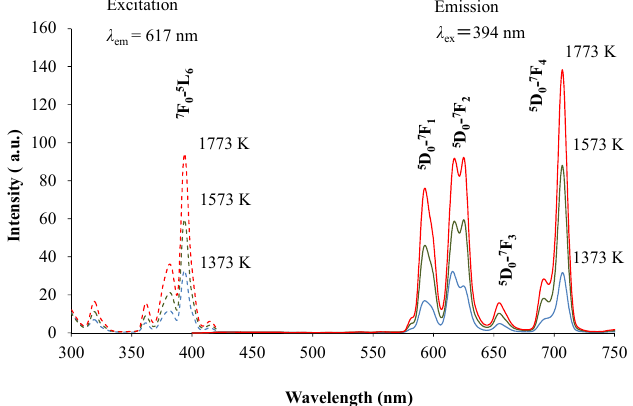
Figure 1. XRD patterns of (Ca 1.95 Eu 3+0.02 □ 0.03 )(Si 0.94 P 0.06 )O 4+ δ annealed at various temperatures from 1373 K to 1773 K for 4 h.